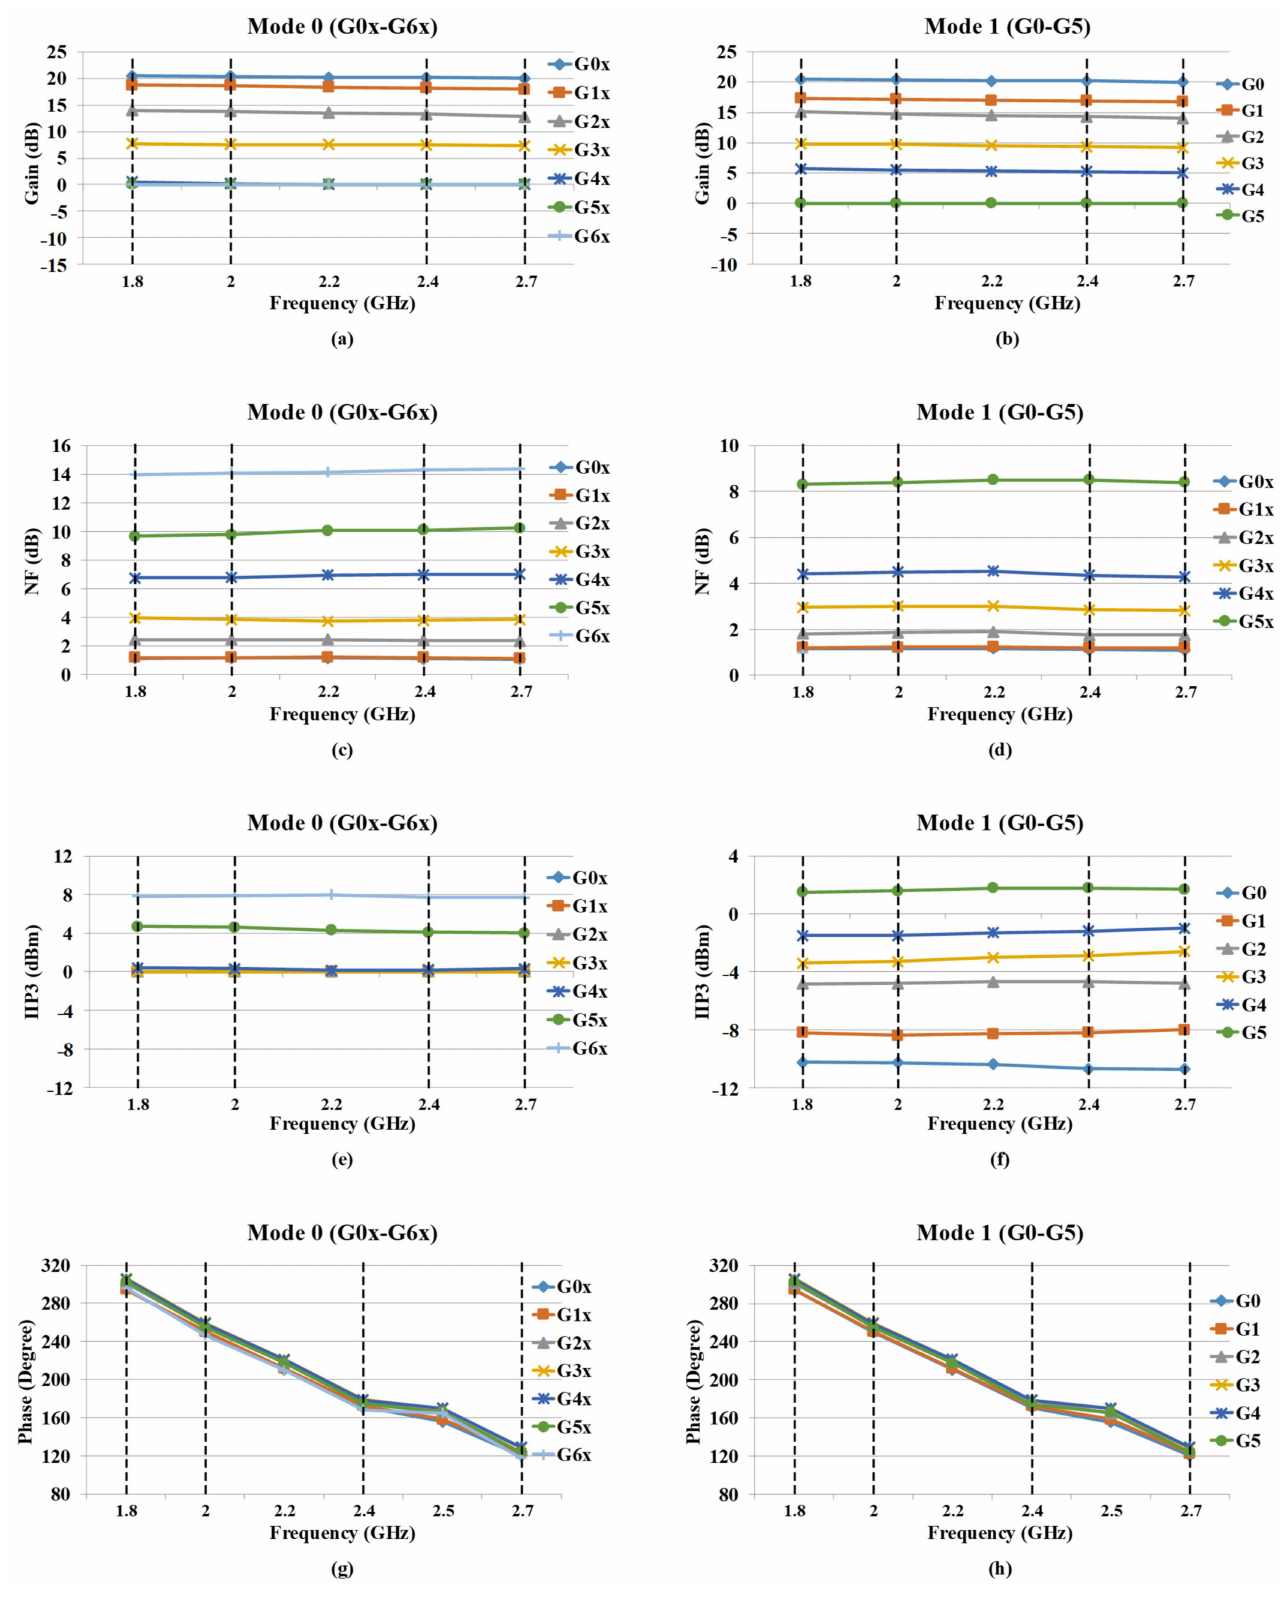
Figure 10. Measured performance graph summary of: ( a ) Mode0 power gain steps, ( b ) Mode1 power gain steps, ( c ) Mode0 NF, ( d ) Mode1 NF, ( e ) Mode0 IIP3, ( f ) Mode1 IIP3, ( g ) Mode0 output phase, ( h ) Mode1 output phase, in LB (1.8–2 GHz), MB (2–2.4 GHz), and HB (2.4–2.7 GHz),